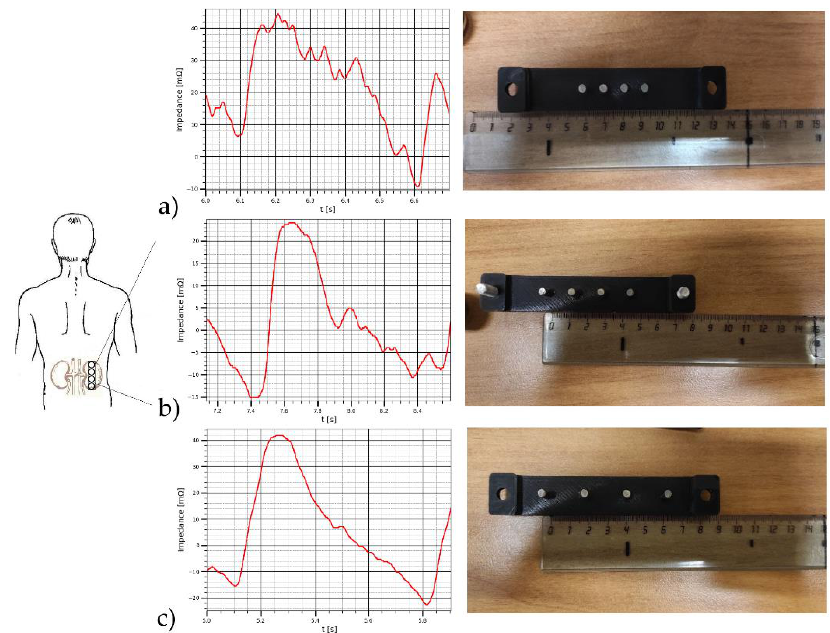
Figure 8. The electrical impedance signals obtained by ( a ) the first electrode system, ( b ) the second electrode system, ( c ) the third electrode system. Table 6. The results of bio-impedance measurement on subject. Distance between the Current Electrodes [mm]